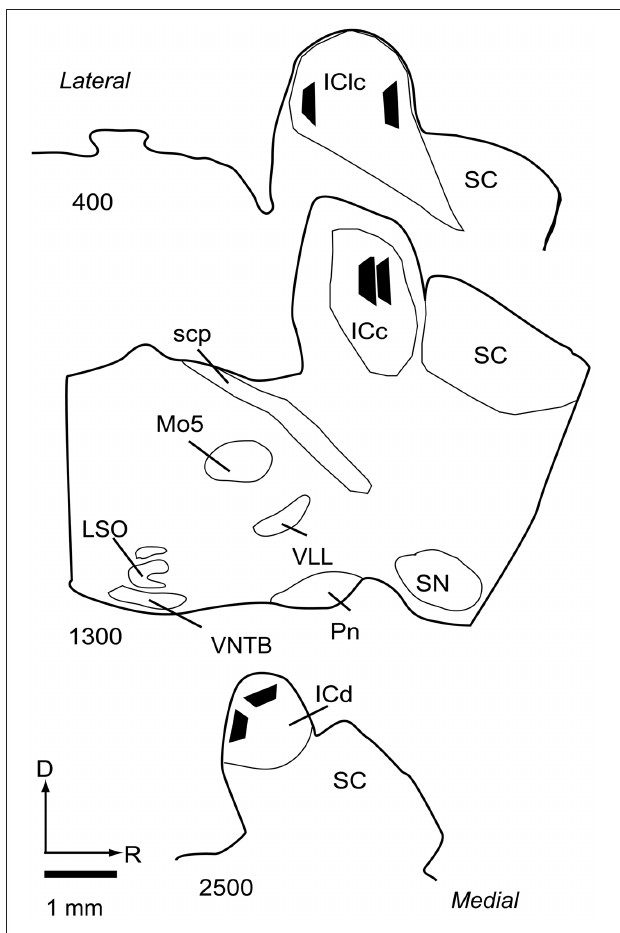
FIGURE 2 | Line drawings of parasagittal sections through the IC showing the locations of the 6 tissue blocks collected for analysis. Two blocks were collected from each of 3 subdivisions of the IC. Each black trapezoid represents the position of a single tissue block. Samples were taken from multiple sections across several animals, but are drawn on a single representative series of sections for ease of comparison. Sections are arranged from lateral to medial; the numbers at lower left of each section indicate approximate distance of the section, in µ m, from the lateral-most section in the series. Abbreviations: D, dorsal; ICc, central nucleus of the inferior colliculus; ICd, dorsal cortex of the inferior colliculus; IClc, lateral cortex of the inferior colliculus; LSO, lateral superior olive; Mo5, motor trigeminal nucleus; Pn, pontine nuclei; R, rostral; SC, superior colliculus; scp, superior cerebellar peduncle; SN, substantia nigra; VLL, ventral nucleus of the lateral lemniscus; VNTB, ventral nucleus of the trapezoid